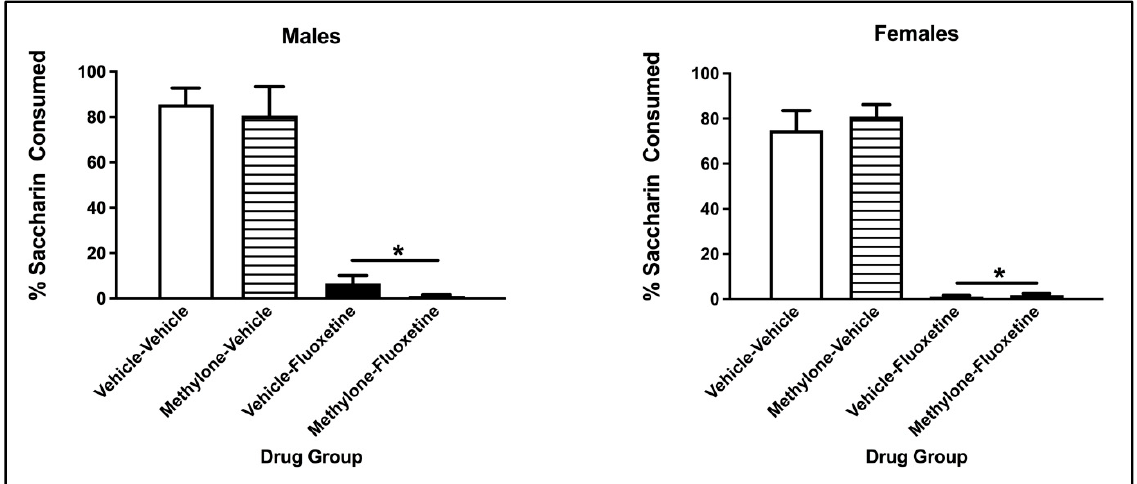
Figure 4. Mean (+/ − SEM) percent saccharin consumed by male ( left ) and female ( right ) subjects injected with saline (vehicle) or methylone during pre-exposure and conditioned with vehicle or 10 mg/kg of fluoxetine ( n = 8–9 per group for both males and females). * Subjects conditioned with fl uoxetine (regardless of pre-exposure condition) signi fi cantly di ff ered from controls.